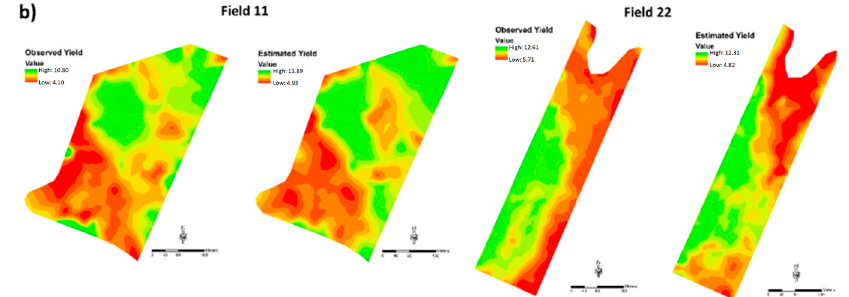
Figure 4. Predicted corn yield maps generated based on the simple meta-function (OLS) for two fields (F1 and F13) without spatial autocorrelation ( a ); and yield map based on the spatial meta-function (SPL) for two fields (F11 and F22) with spatial correlation ( b ) all versus end-season yield data (yield monitor).